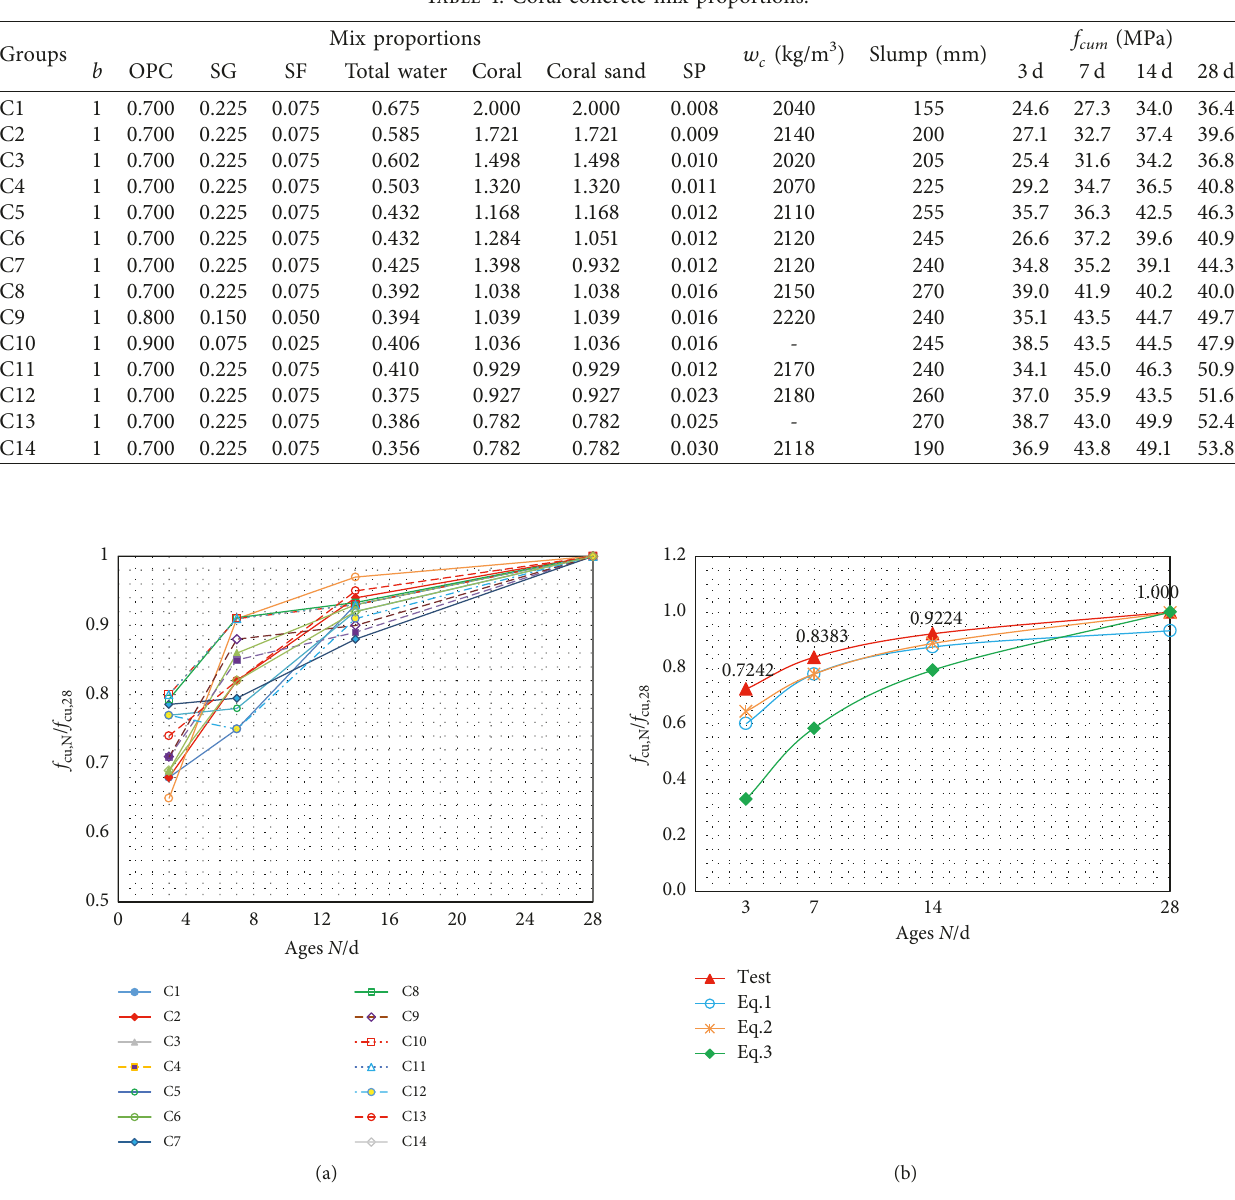
Figure 2: Relationship between (f) cu,N /(f) cu,28d and age measured in this experiment. (a) Relationship between f cu,N / f cu,28d and age. (b) Comparison of test results with predicted